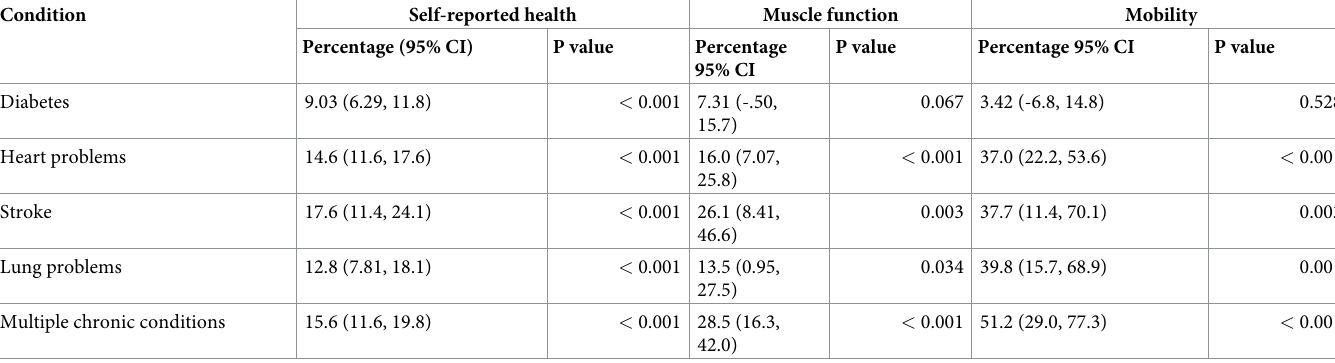
Table 4 gives the associations from the adjusted regression models of age group, sex, and body mass index group with self-reported health, large muscle function and mobility by Table 2. Percentage increase from baseline scores at the first wave after disease incidence in self-reported health, large muscle function, and mobility by chronic disease. Condition Self-reported health Muscle